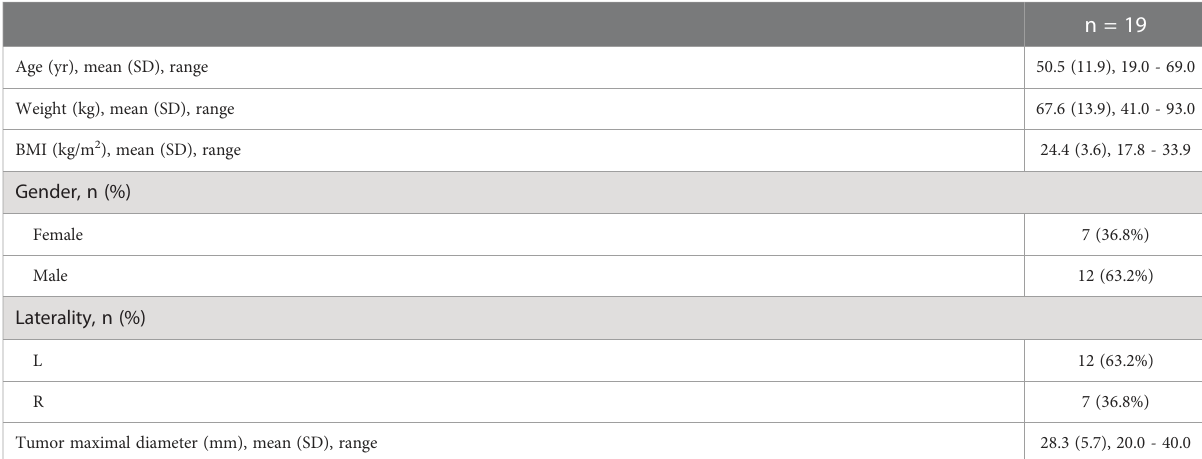
TABLE 1 Demographics and preoperative